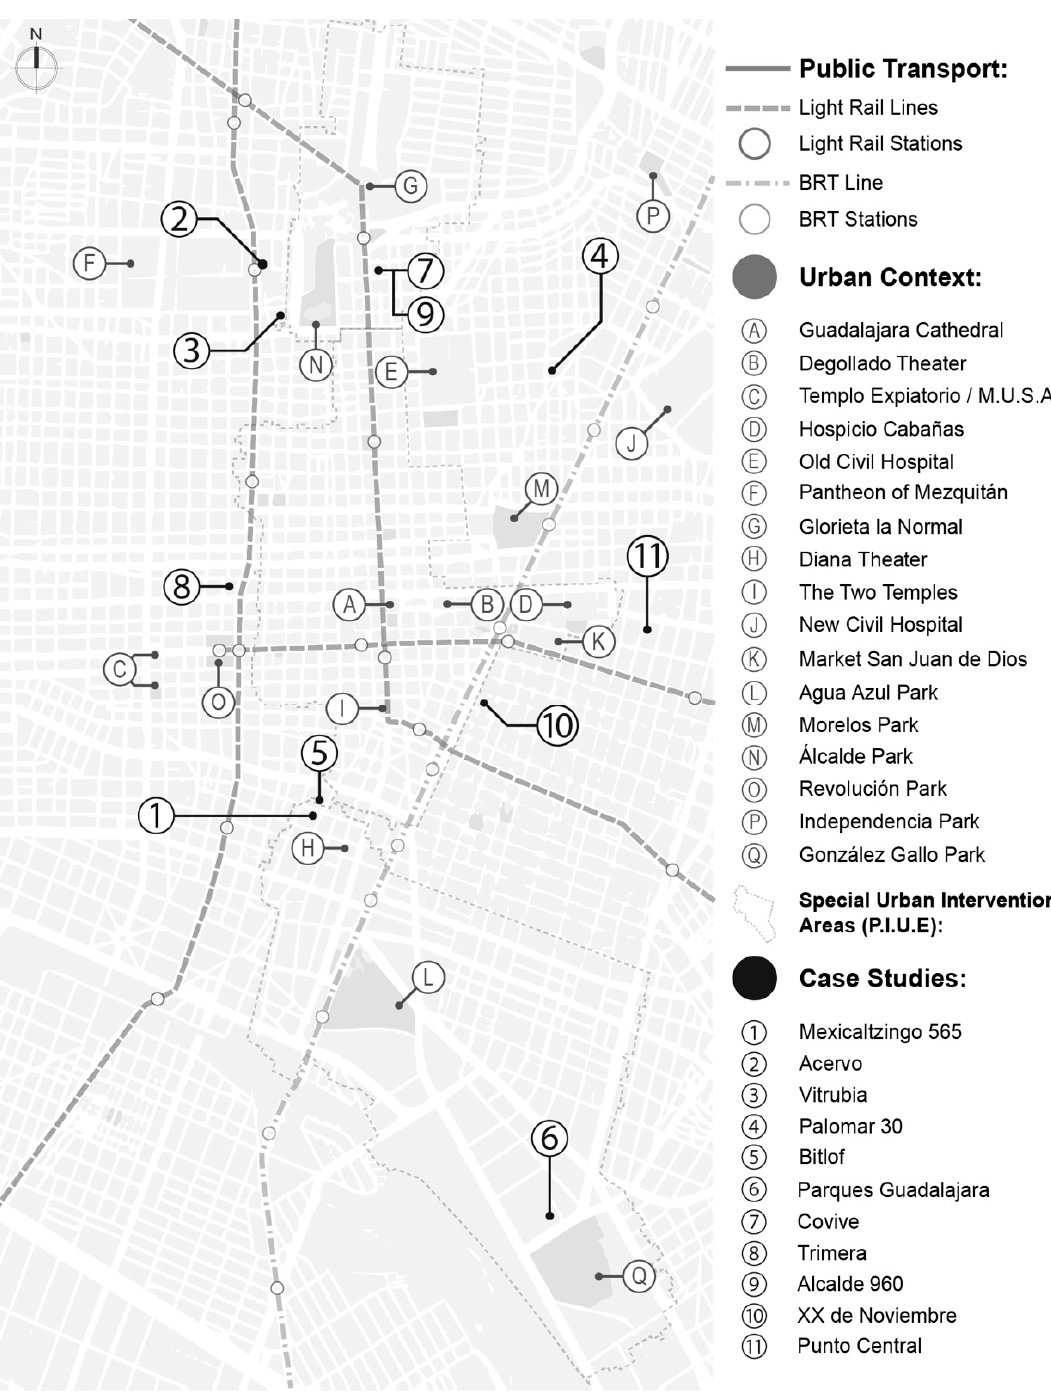
Figure 7. Location plan of the 11 study cases, showing the main urban spots (A to Q) and the principal long distance rapid transport lines and stations. Source own elaboration.